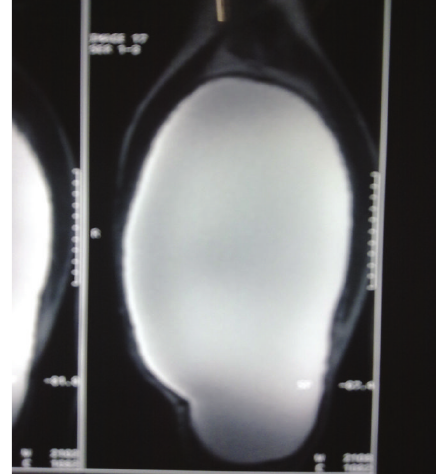
Figure 2: MRI right lower limb showing large cystic mass.